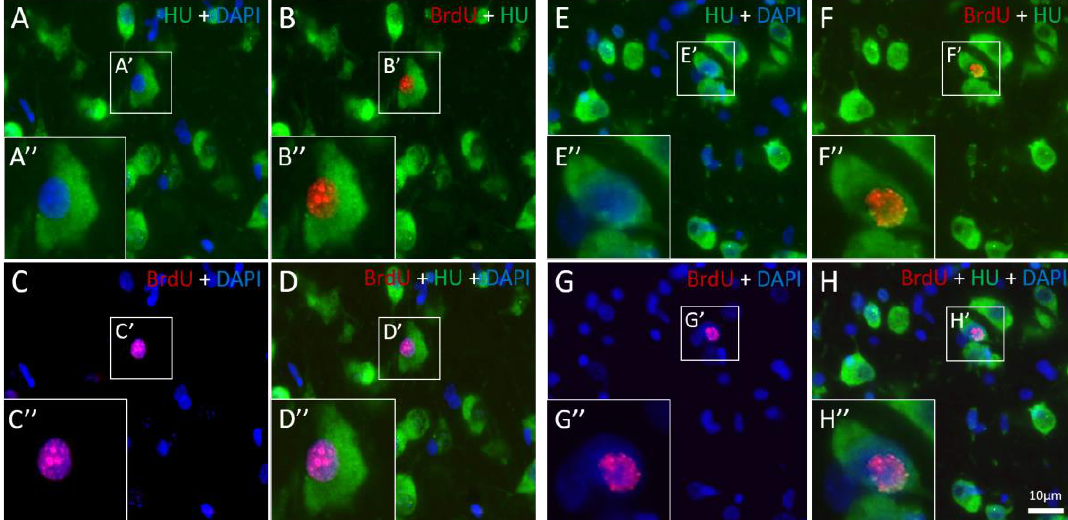
Figure 6. New neurons shown in microphotographs of the same field, ( A – D ) in the medial striatum (MSt); and ( E – H ) in the nidopallium caudale (NC) in the brain of a zebra finch ( Taeniopygia guttata ). HU staining (green) indicates neurons, BrdU staining (red) indicates nuclei of new neurons, and DAPI staining (blue) indicates cell nuclei. Overlapping of BrdU and DAPI staining is expressed as purple. Small frames (-′) indicate BrdU-HU co-labelled neurons, and big inserts (-″) are higher magnifications of these neurons. The scale of 10 µ m in H applies to A – H .